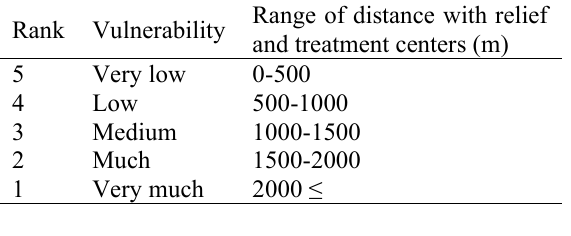
Table 7. Vulnerability and its ranking based on building